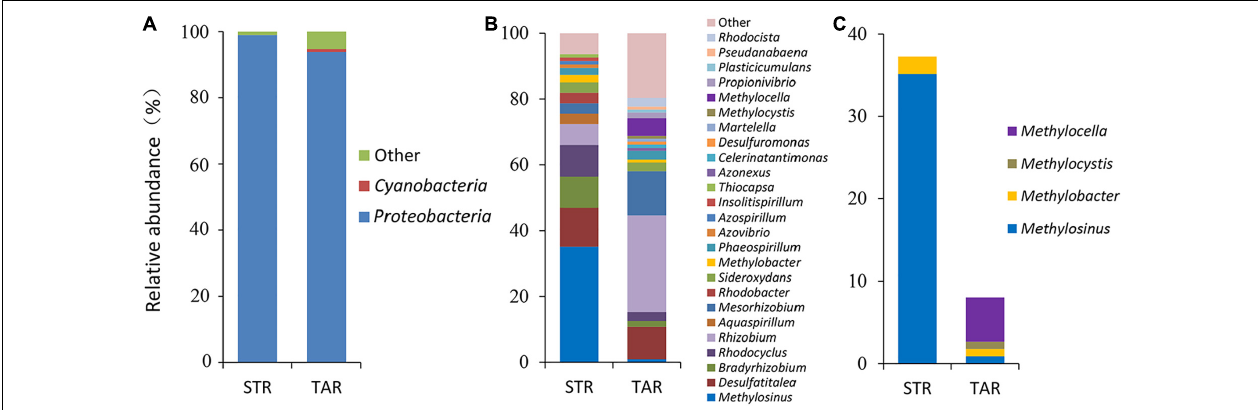
FIGURE 3 | Relative abundance of active root-associated diazotrophic bacterial communities at the phylum (A) and genus (B) level and diazotrophic methanotrophic communities (C) in TAR and STR plants at the genus level based on a cDNA analysis of the nifH gene. TAR, Typha angustifolia roots; STR, Scirpus triqueter